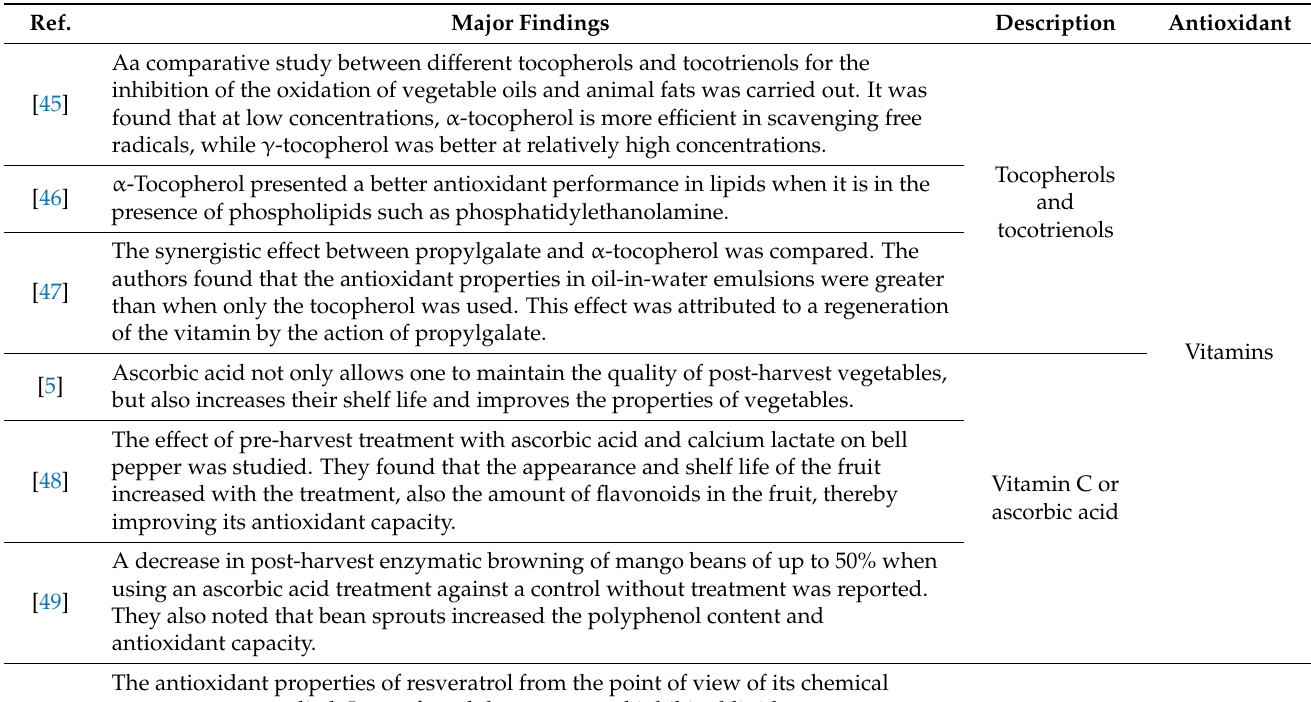
Table 1. Summary of the major findings of the applied research in the use of antioxidants for the preservation of foods.